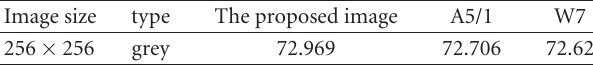
Table 4: MAE test results for Lena standard.